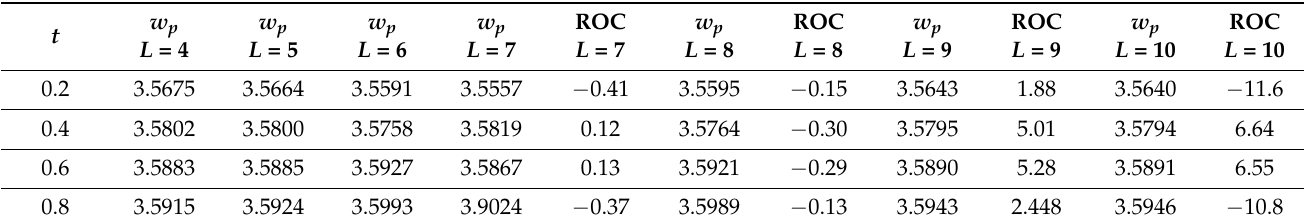
Table 13. The values of w p and rate of convergence (ROC) at different points for k = 0 and various values of L by sine– cosine wavelets.